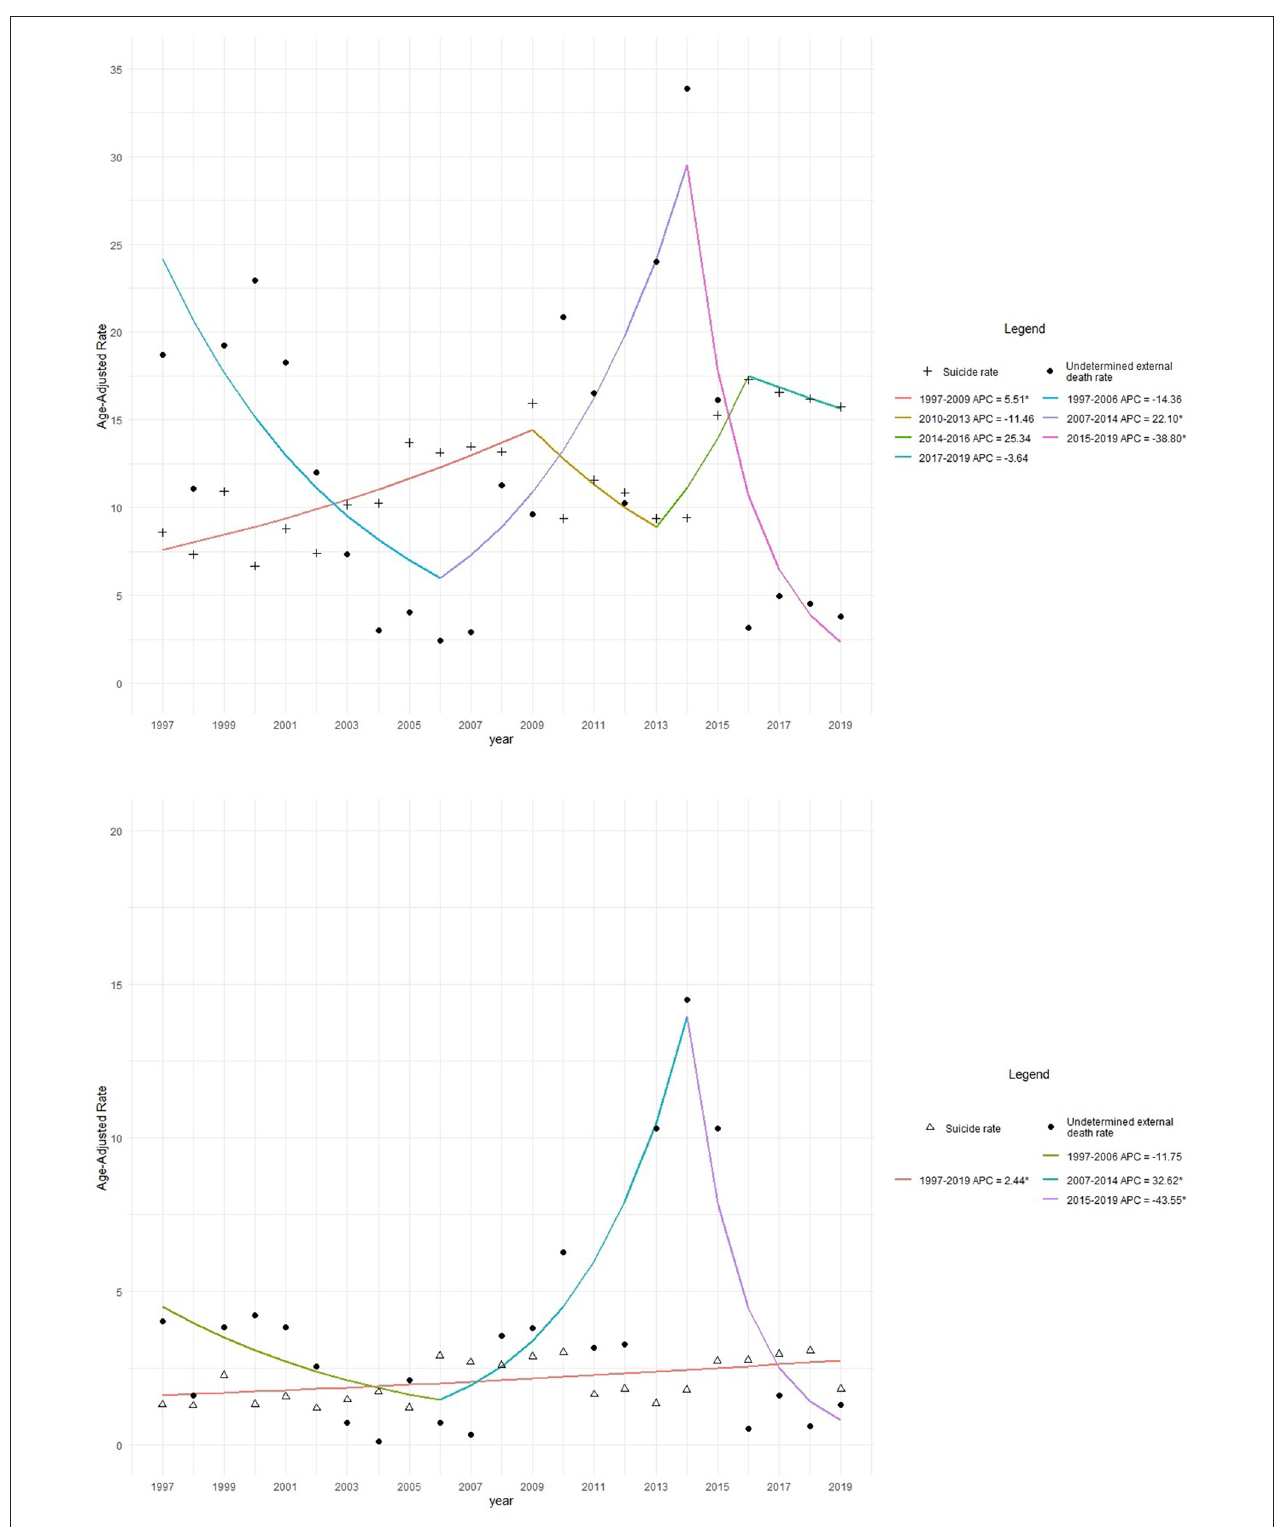
FIGURE 1 | Joinpoint analysis. Age-adjusted suicide and undetermined death (UD) rates in older adults by sex among men and women aged 60 years and older in Ecuador, 1997–2019. (A) Age-adjusted suicide and undetermined death (UD) rates in men aged 60 years and older in Ecuador, 1997–2019. (B) Age-adjusted suicide and undetermined death (UD) rates in women aged 60 years and older in Ecuador, 1997–2019.